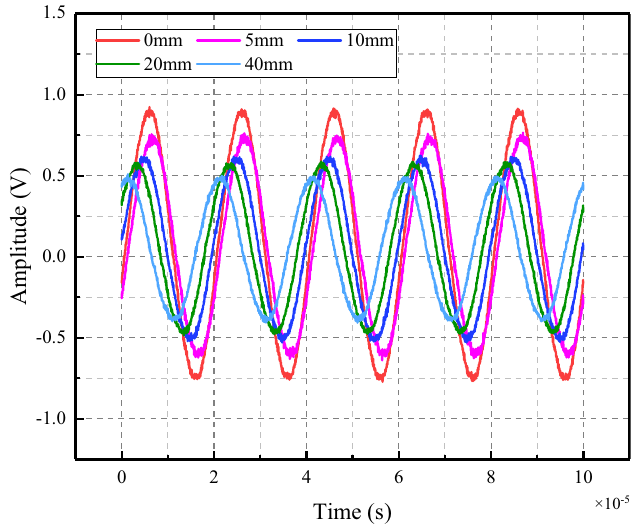
Figure 9. Time domain signal diagram received by PZT